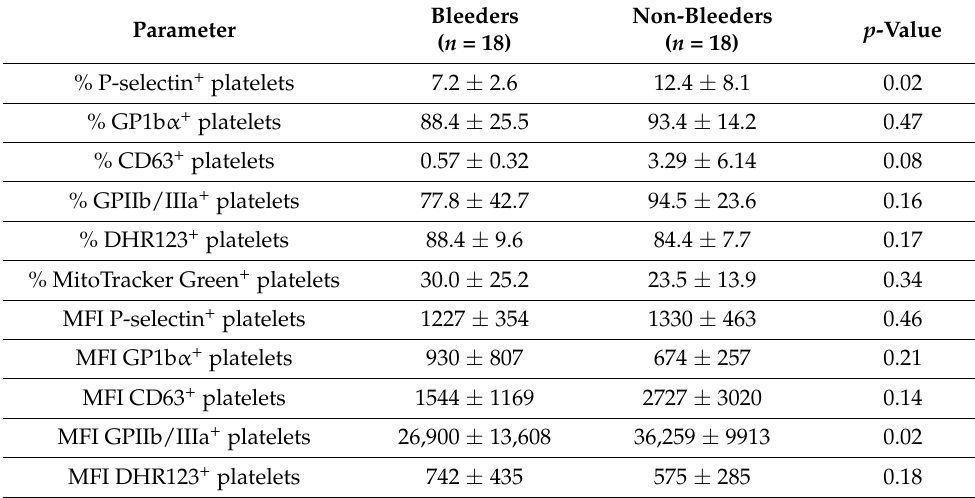
Table 6. Flow cytometric analysis of platelet receptor expression and oxidative stress in LVAD patients with and without NSB prior LVAD implantation.